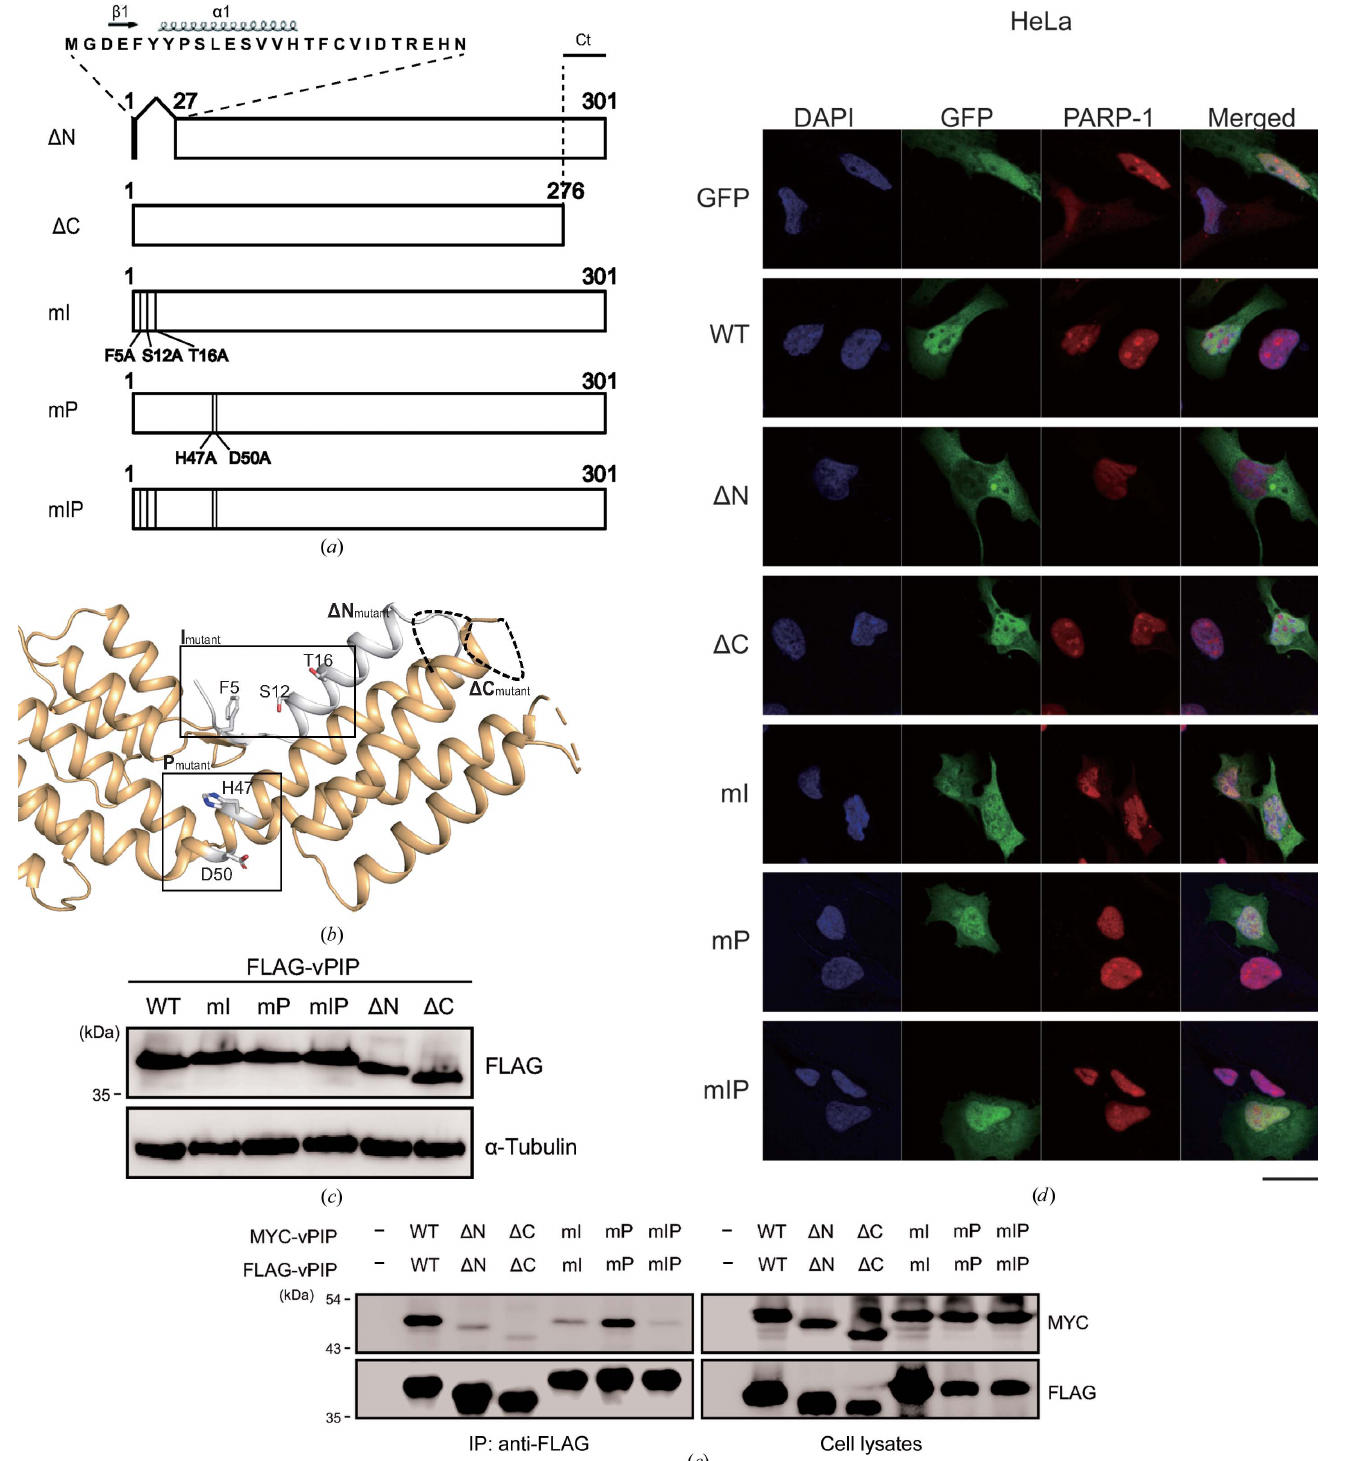
Figure 2 Construction and characterization of vPIP mutants. ( a ) Schematic diagram of vPIP deletion and point mutants. Two deletion mutants, vPIP (cid:2) N (deletion of amino acids 2–26) for N (cid:3) and (cid:2) 1 and vPIP (cid:2) C (deletion of amino acids 277–301), and two point mutants, vPIP mI (F5A, S12A and T16A) for interaction sites and vPIP mP (H47A and D50A) for pore sites, were constructed. An additional mutant containing both mI and mP was also generated (vPIP mIP). ( b ) The structure of vPIP mutations with positional indicators. The positions of the mutations are marked in the monomer structure of vPIP. ( c ) Expression of vPIP mutants. FLAG-tagged vPIP mutant constructs were transfected into HeLa cells. After 24 h, expression of the vPIP mutants was analyzed by Western blotting. ( d ) Subcellular localization of vPIP mutants. HeLa cells were transfected with the GFP-tagged vPIP mutants, fixed at 24 h post-transfection and immunostained with anti-PARP-1 antibody. The nuclei were stained with DAPI (blue). The scale bar is 20 m m in length. ( e ) Dimerization of vPIP mutants. MYC-tagged vPIP mutants were co-transfected with FLAG-tagged vPIP mutants into HEK293T cells for 48 h. The cells were harvested and subjected to co-IP assays using anti-FLAG. The results were analyzed by Western